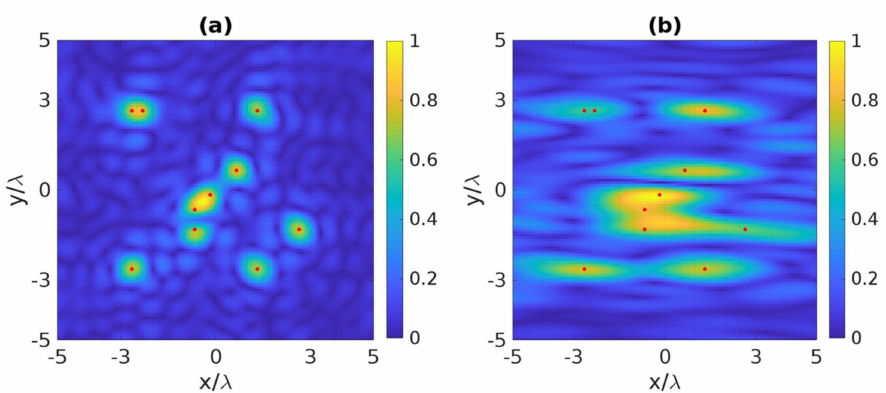
Figure 12. The normalized reconstructed image of ten point-like scatterers: ( a ) angle mode, ( b ) re- ceiving mode. The red dots indicate the position of the scatterer